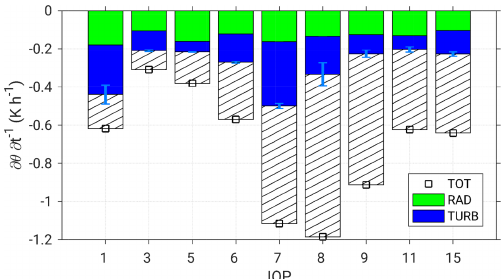
Figure 12. Vertically averaged temperature tendency (TOT), ra- diative flux divergence (RAD) and sensible heat flux diver- gence (TURB) for individual IOPs. The values are averaged up to the height of the LLJ axis and calculated for a period within the jet phase (Fig. 2). The hashed area indicates the amount of cooling that cannot be explained by neither RAD nor TURB. The error bar for TURB results from the usage of the surface sensible heat fluxes from two energy balance stations.